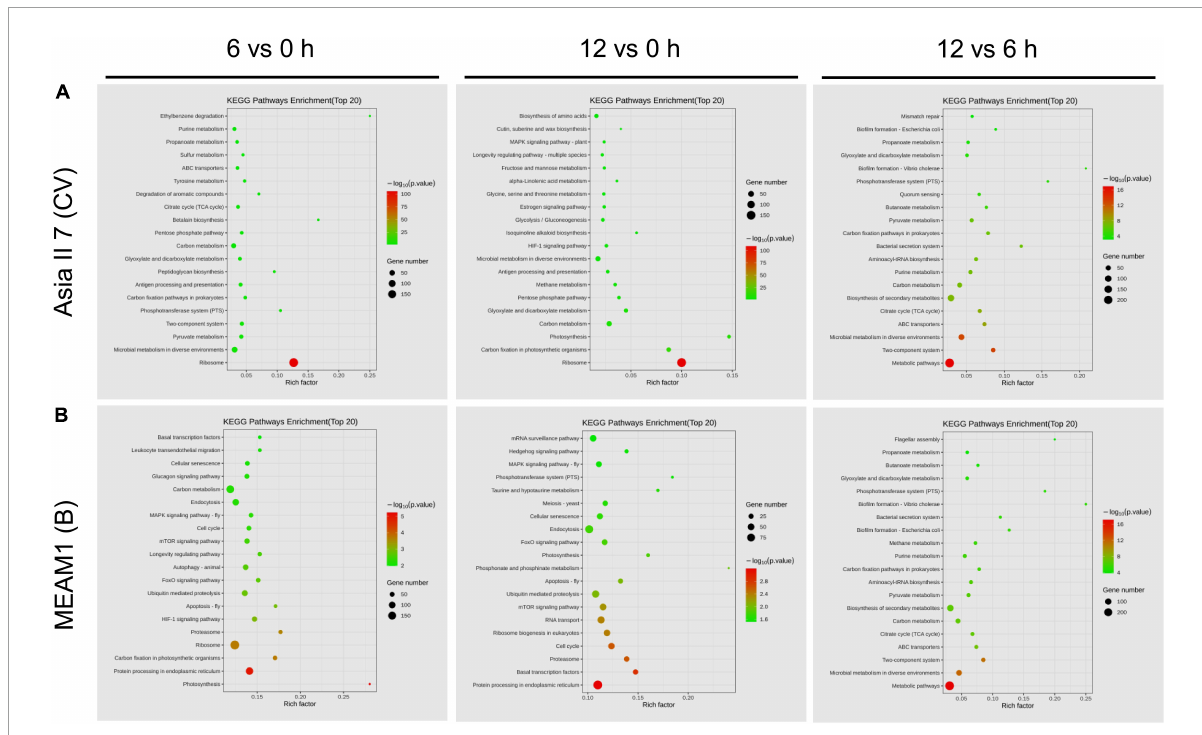
FIGURE6 The Kyoto Encyclopedia of Genes and Genomes (KEGG) pathway enrichment plot among different comparative groups of viruliferous (VF) and aviruliferous (AVF) whiteflies [Asia II 7 (A) and MEAM1 (B) ]. The vertical scale represents top 20 enriched pathways (path factor) while the horizontal scale represents the rich factor corresponding to the path factor. The dot color represents high (red) to low (green) changes in the size of p -value whereas the dot size represents the number of genes enriched in each pathway.